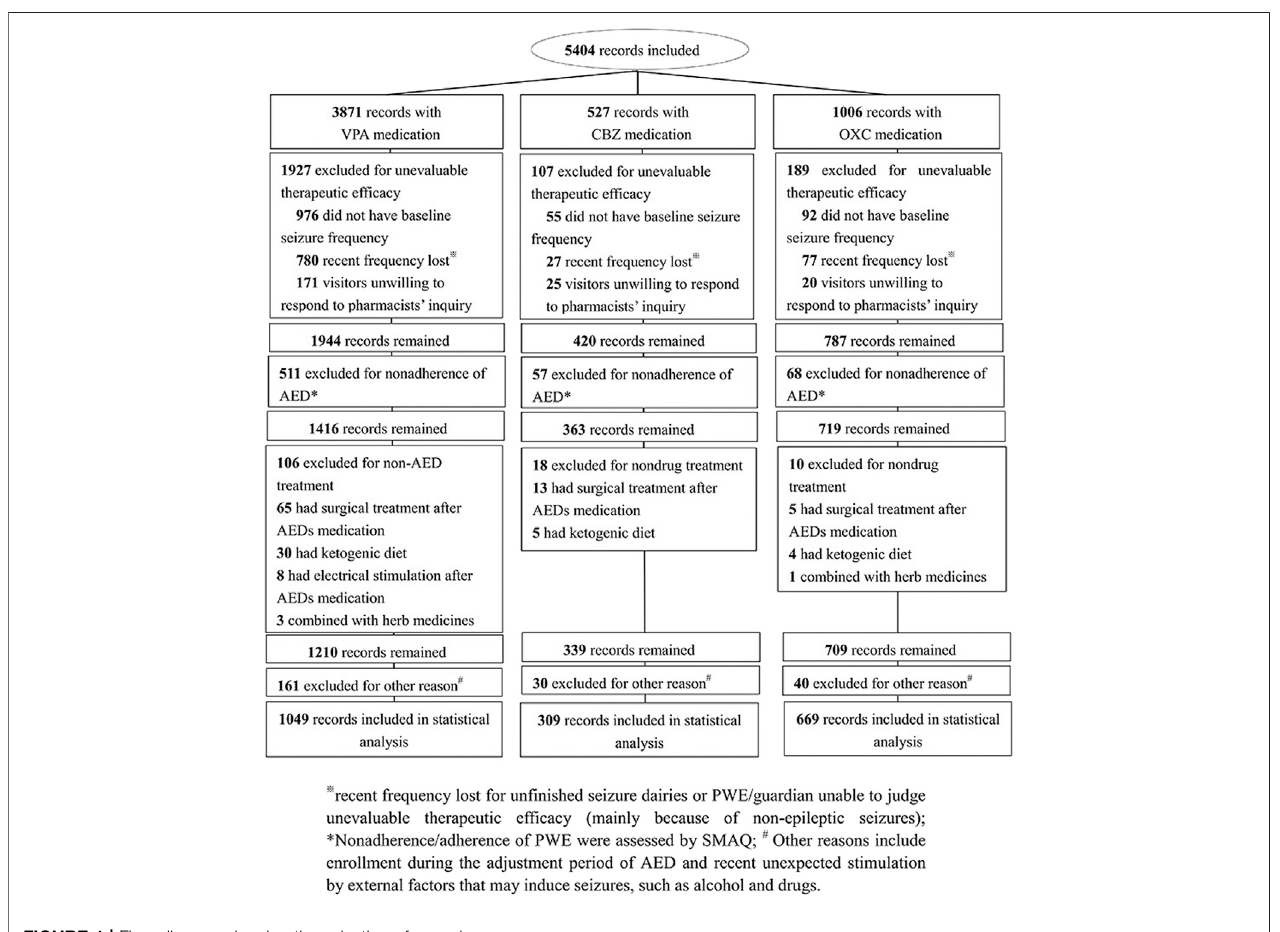
FIGURE 1 | Flow diagram showing the selection of records.